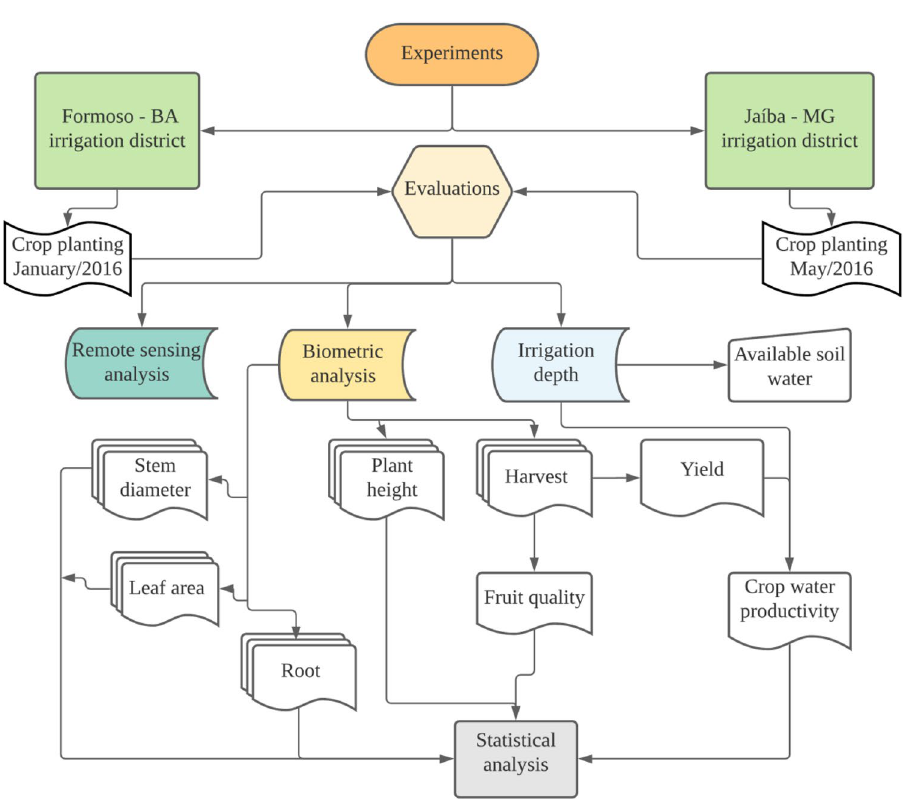
Figure 2. Step-by-step flowchart to show the stages of implementation, collection and analysis of data from the